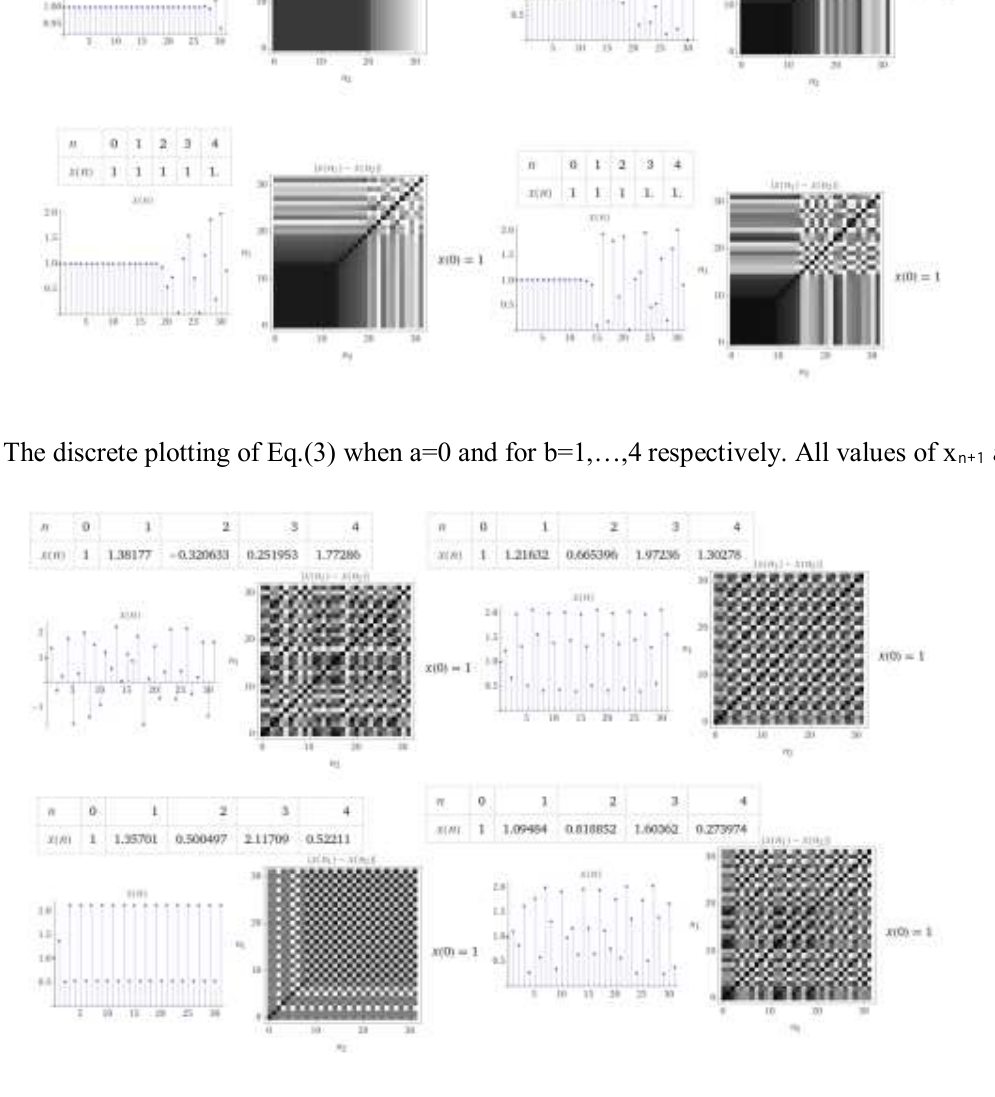
Figure 2. The discrete plotting of Eq.(3) when a=1, 0.5 (first column) 0.25, 0.1 (second column), and for b=1,